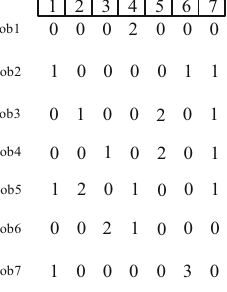
also located in the same position in two parents, which was put into position 3 of offspring 1 and 2, respectively. To obtain the genes for the unfilled position of offspring 1, a crossover point is randomly generated between